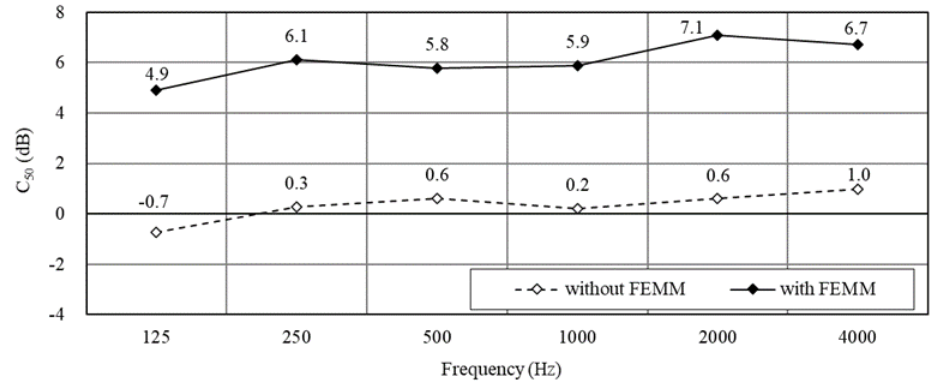
Figure 20. Comparison of speech clarity ( C 50 ) at each band.